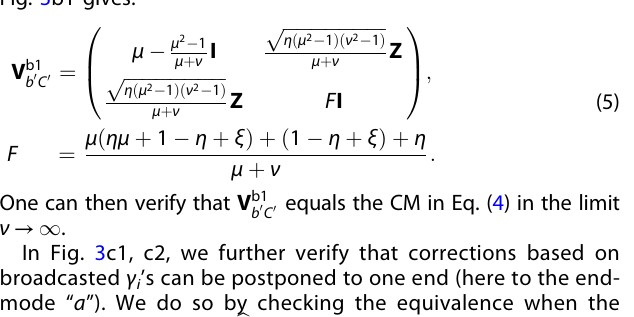
ffiffiffiffiffiffiffiffiffiffiffiffiffiffiffiffiffiffiffiffiffiffi p η 0 ð μ 0 2 (cid:1) 1 Þ